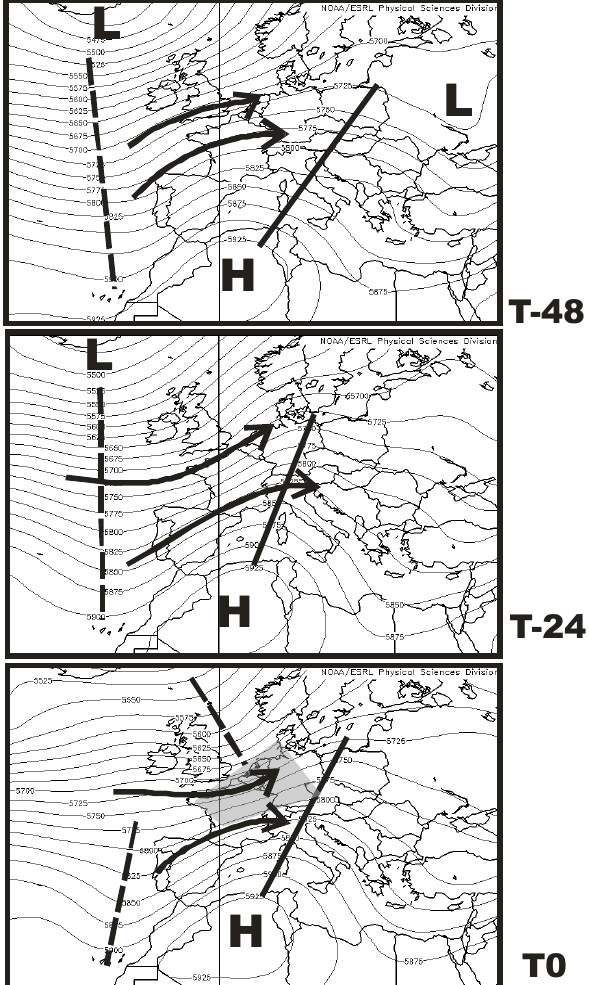
Figure 4. Composite time series at 500hPa for group one consisting of eight STH events. Heights contours at 100gpm are highlighted (contour interval is 25gpm). Dashed lines indicate troughs while solid lines represent ridges in 500hPa flow. Arrows indicate flow trajectories and shading suggests areas where vertical motion would be expected with flow